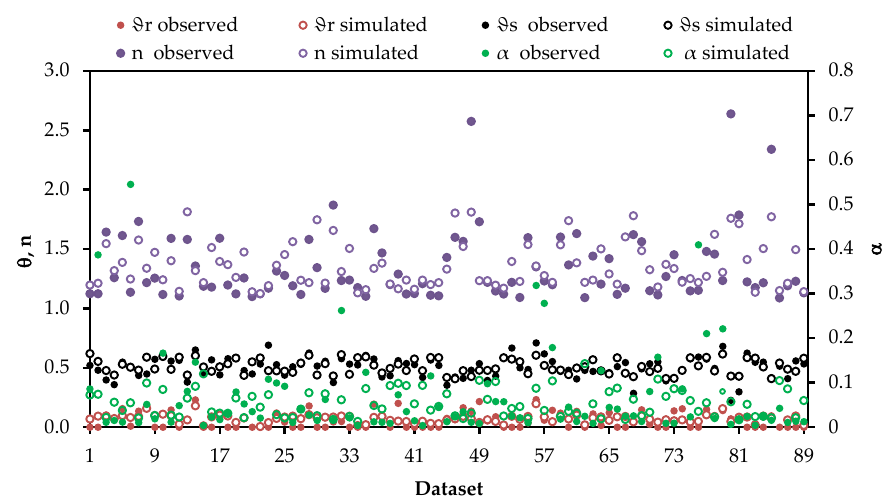
Figure 5. Observed and simulated vG parameters obtained by ANN4.